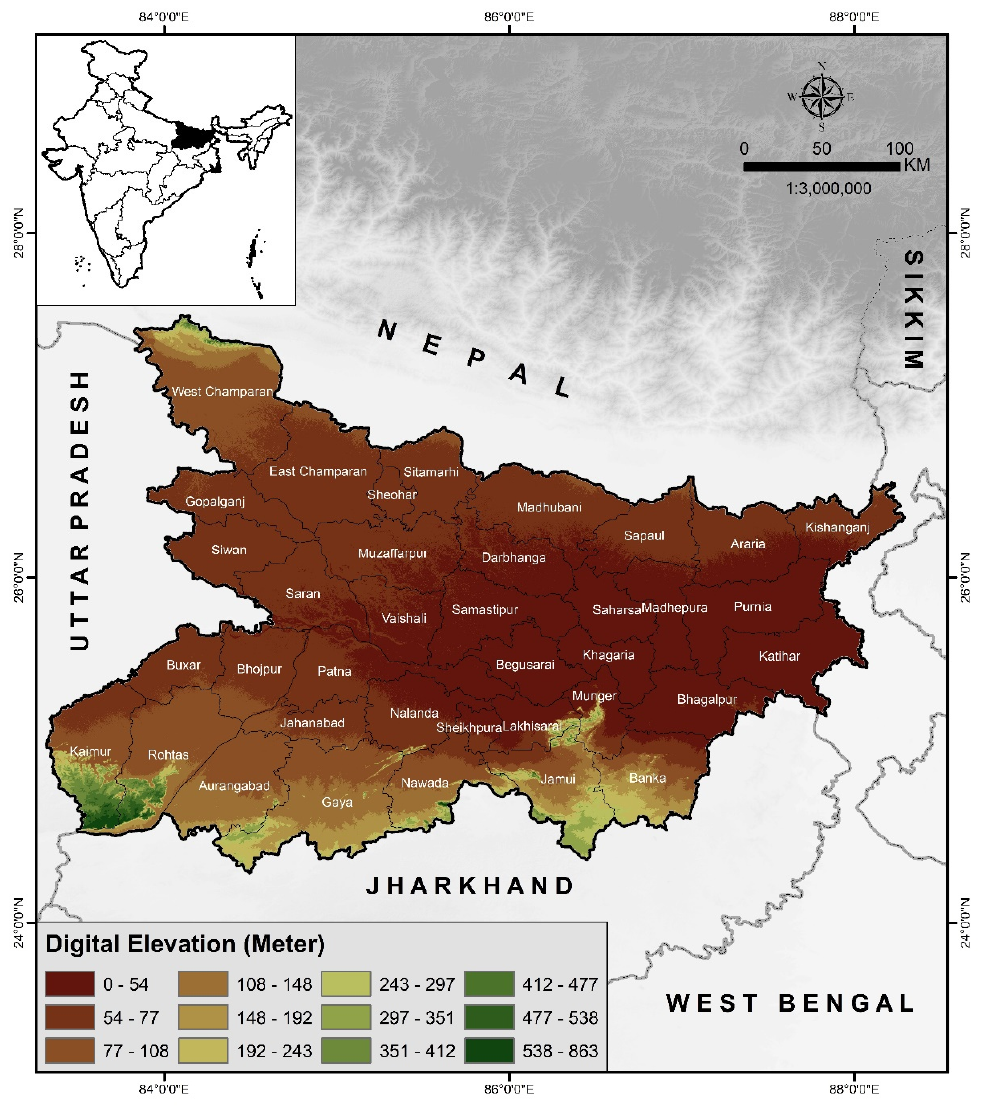
Figure 1. Topography map of the study area, Bihar, located in India, showing elevation.